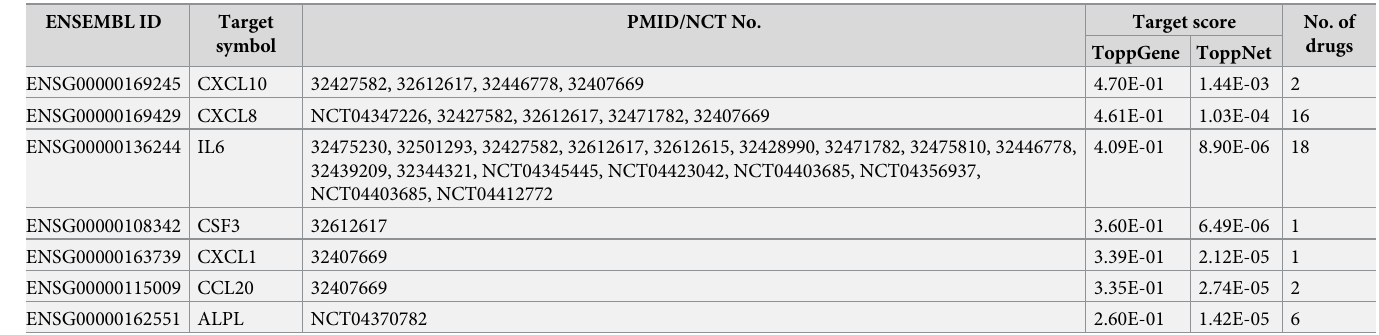
Table 2. SARS-CoV-2 triggered gene expression signature revealed potential anti-COVID-19 drug targets from existing approved and clinical trial drugs. ENSEMBL ID